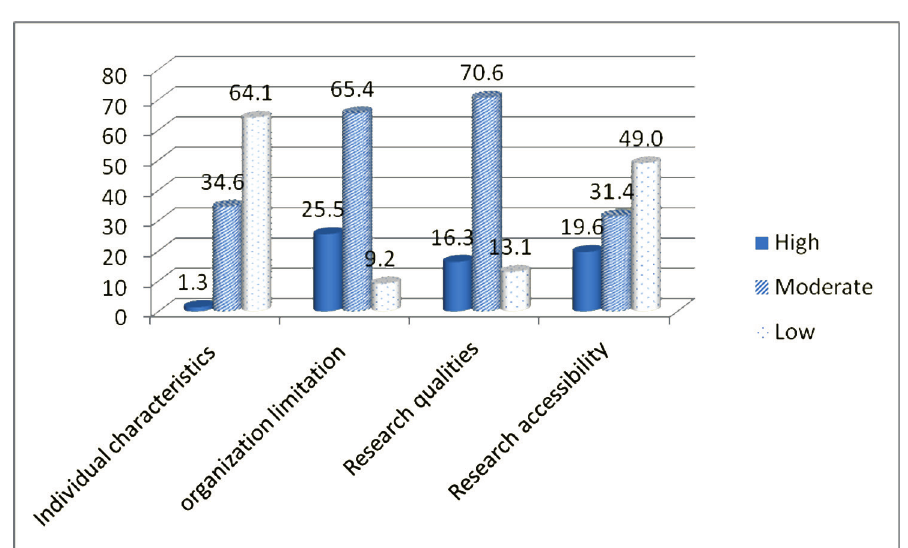
Figure 1. Ranking EBP obstacles as perceived by nurses ( N